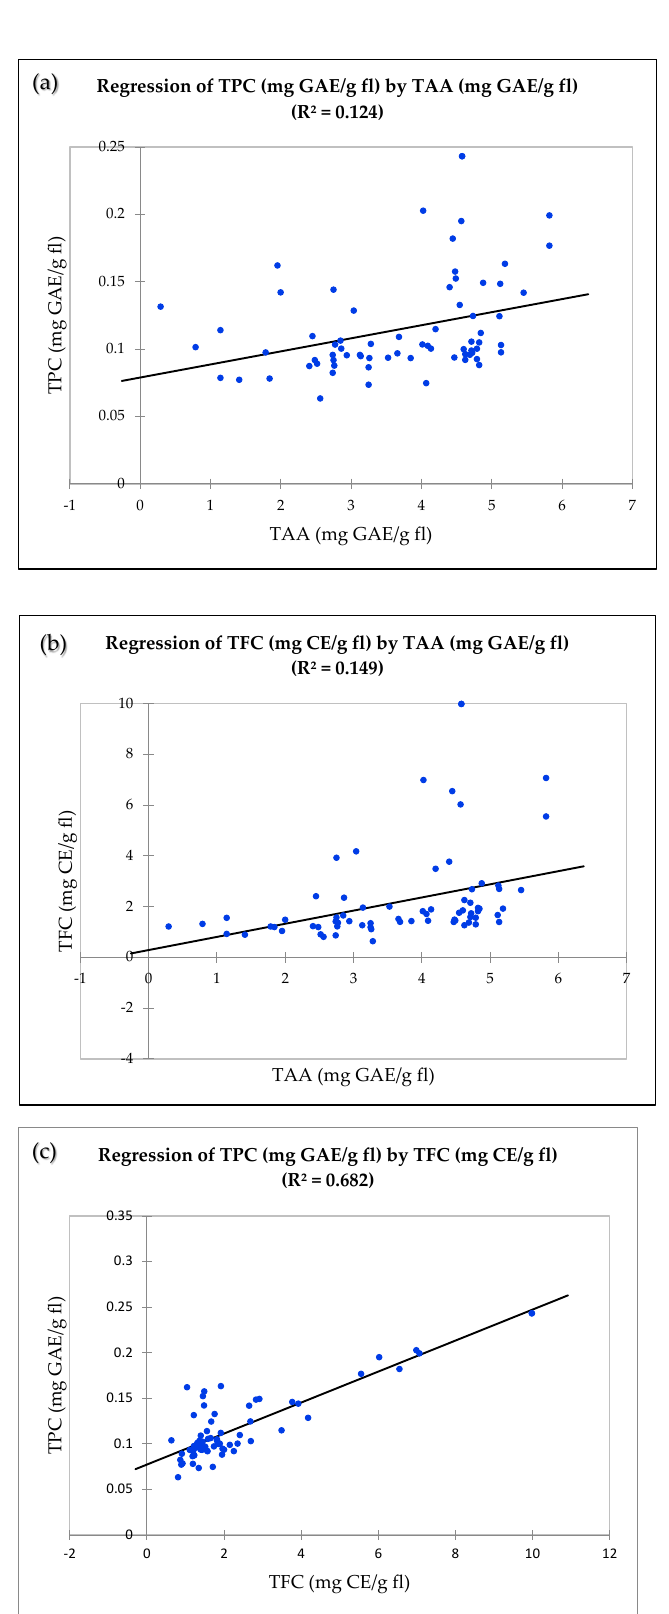
Figure 1. Linear regression between antioxidant properties in wild clones, cultivars, and hybrids. ( a ) Total antioxidant activity by DPPH (mg GAE/g fl) and total phenolic content (mg GAE/g fl). ( b ) Total antioxidant activity by DPPH (mg GAE/g fl) and total flavonoid content (mg CE/g fl). ( c ) Total phenolic content (mg GAE/g fl) and total flavonoid content (mg CE/g